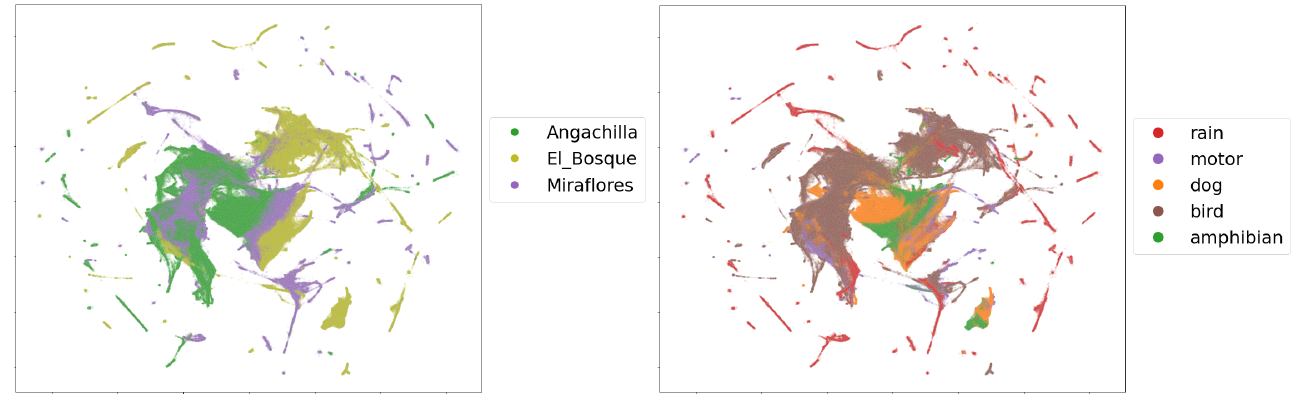
Figure 9. Two-dimensional embedding of UMAP with visual acoustic features for three habitats ( left ) and for the five single-events of reference where multi-events were absent ( right ).